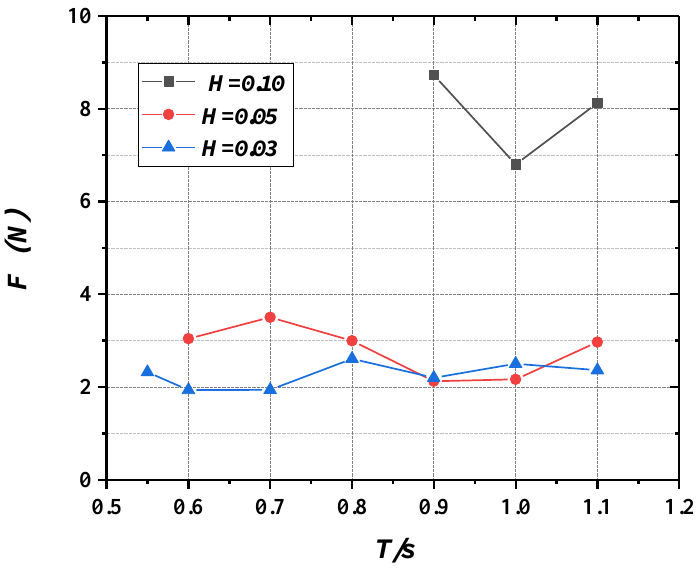
Figure 31. Variations of 2# mooring force.